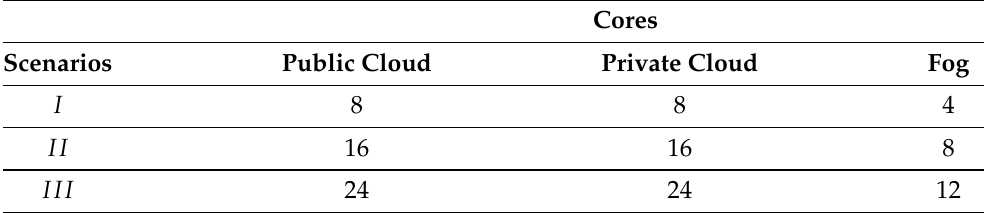
Table 6. Configurations of the computing layers for the performance trade-off analyses.